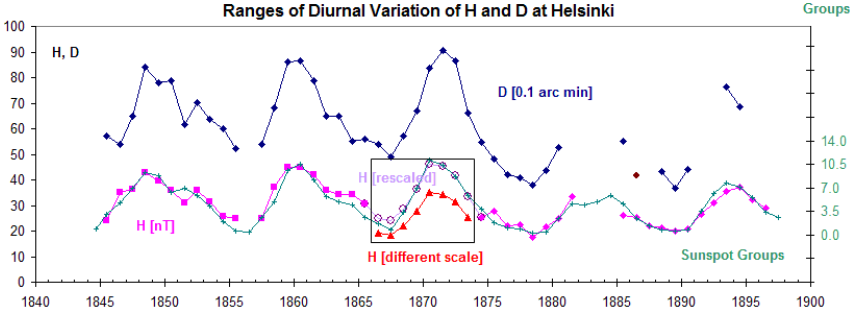
Figure 5. Yearly average ranges for declination D (in 0.1 arc minute units), blue curve, and for horizontal force (in nT units), pink curve. Because of the strong seasonal variation only years with no more than a third of the data missing are plotted. The green curve (with “+” symbols) shows the number of active regions (sunspot groups) on the disk scaled to match the pink curves ( H ). As expected the match is excellent, except for the interval 1866–1874, where the H range would have to be multiplied by 1.32 for a match, purple open circles.